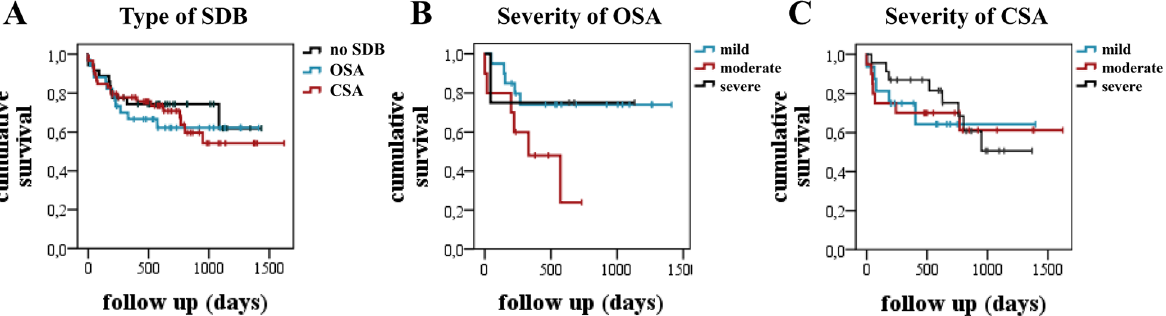
Fig 4. Kaplan-Meier estimate of survival. Kaplan-Meier estimates of survival with regard to the type of sleep disordered breathing (SDB, Panel A) and the severity of obstructive (OSA, Panel B) and central sleep apnoea (CSA, Panel C), respectively, show no significant differences in mortality between the groups. Mild SDB: AHI 5 – 14.9/h, moderate SDB: AHI 15 – 29.9/h, severe SDB AHI > 30/h.